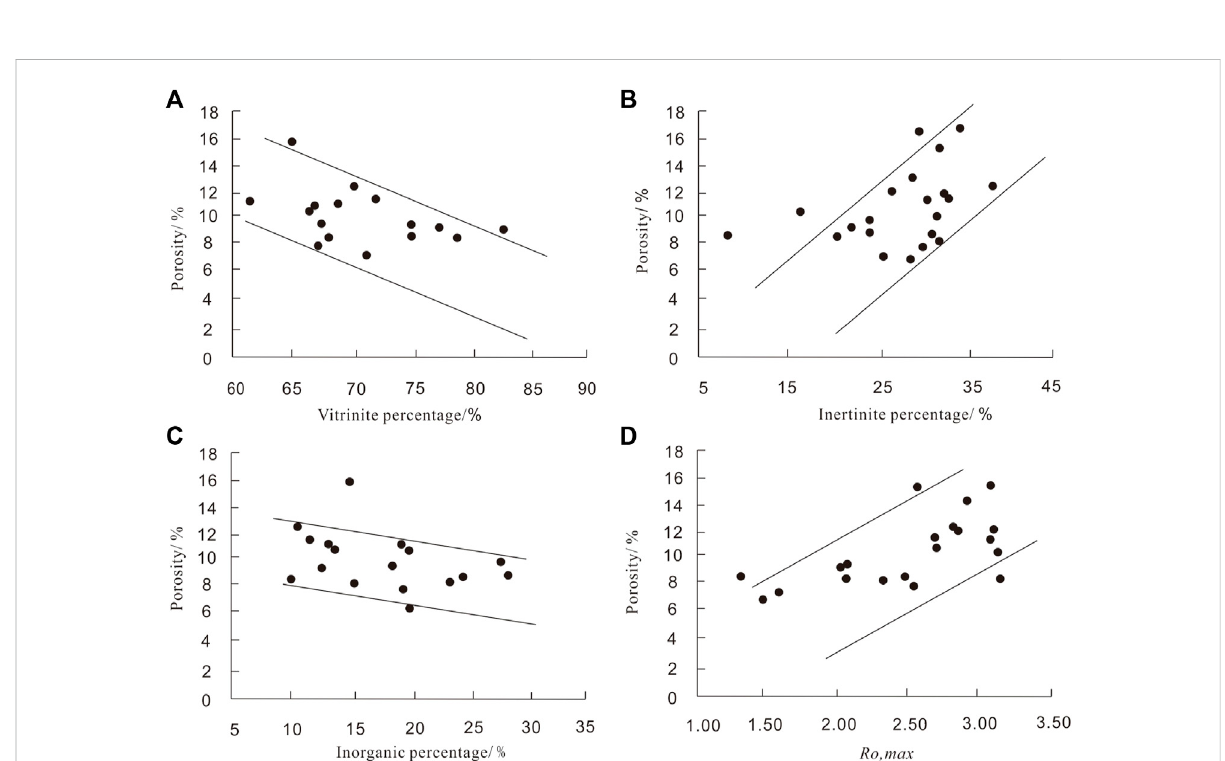
FIGURE 4 Relationships between porosity versus vitrinite (A) , inertinite (B) , inorganic (C) , and maximum vitrinite re fl ectance (D) .